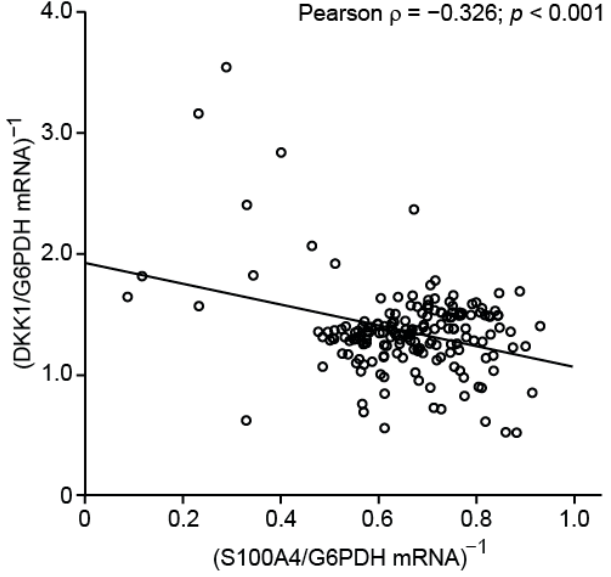
Figure 7. Correlation analysis of S100A and DKK1 mRNA expression of combined GEO datasets of CRC microarray analyses. Expression levels of target genes were normalized to G6PDH.